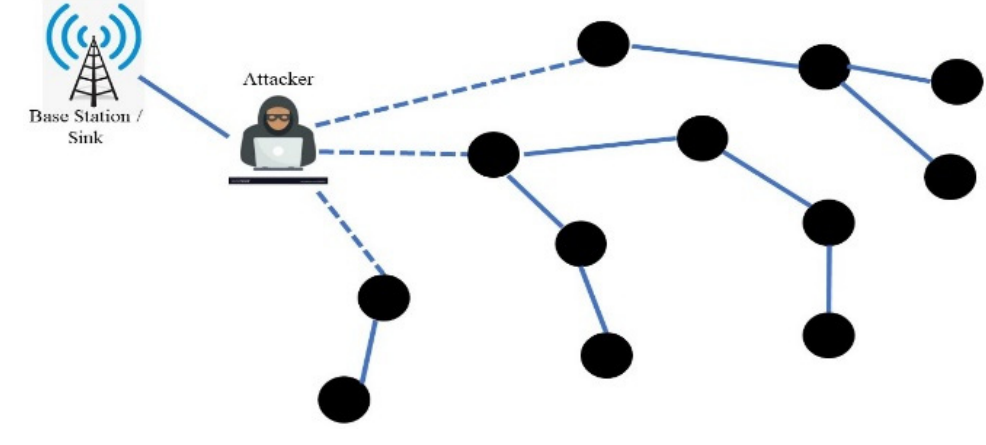
Figure 8. A Black hole attack.